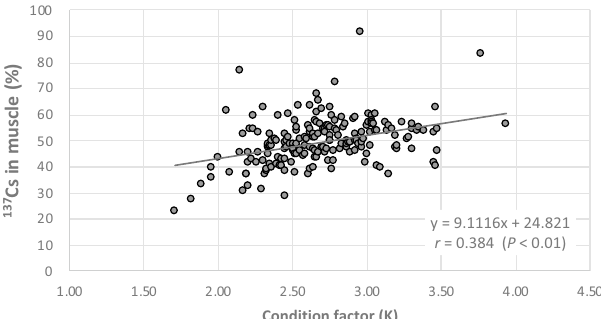
Figure 5. Relationship between the condition factor and the proportion of 137 Cs in muscle of crucian carp. Positive correlation was observed between the two variables (n =